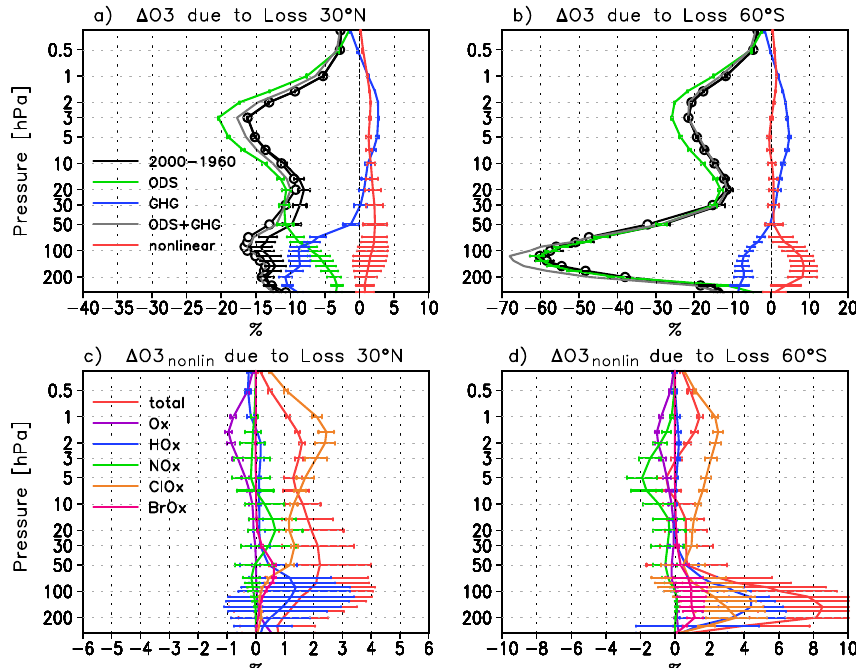
Figure 3. Top panels: vertical profile of the relative ozone change due to chemical ozone destruction (black) and its attribution to GHGs (blue), ODSs (green) and nonlinear interactions (red) for the annual mean at 30 ◦ N (a) and at 60 ◦ S (b) . The results based on the calculation with the tool StratO3Bud are shown as solid lines. For comparison, the result of the total change calculated accordingly to Fig. 2b is shown as black line with circles. Bottom: vertical profile of the nonlinear contribution to the loss-induced ozone change (red; see top panel) and the separation into the contributions from the different ozone loss cycles, i.e. the O x (purple), HO x (blue), NO x (green), ClO x (orange) and BrO x (magenta) loss cycles for the annual mean at 30 ◦ N (c) and at 60 ◦ S (d) . The bars denote the 95% confidence level of the changes. The contributions from the single loss cycles add up to the total loss change. Note the different scales of the subfigures.